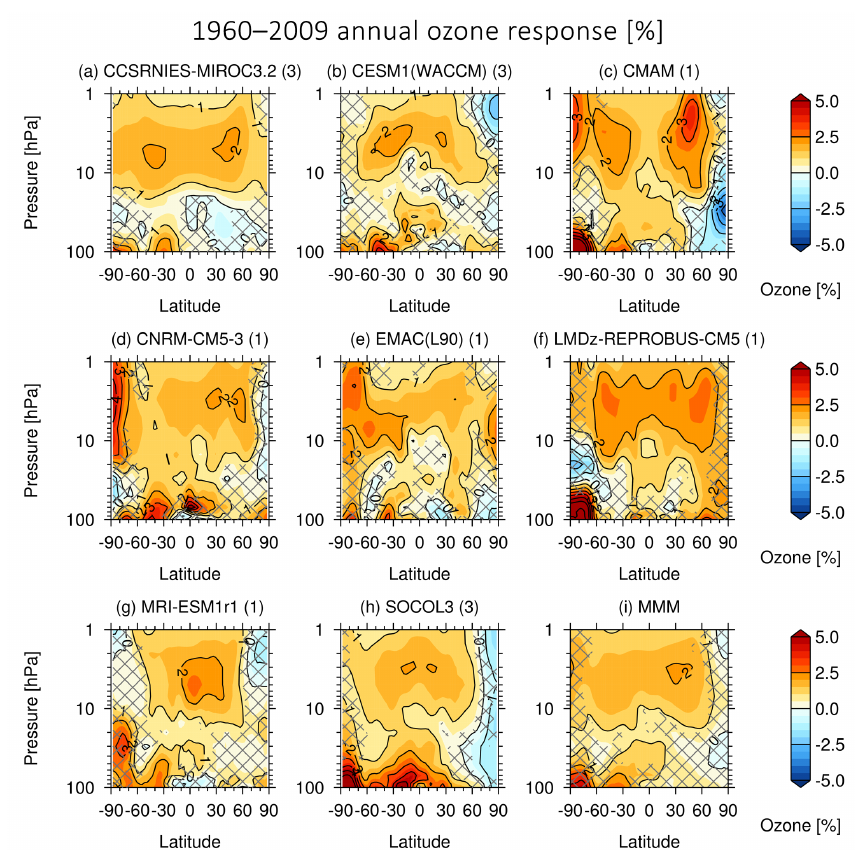
Figure 3. The percent (%) differences in stratospheric ozone mixing ratios per 130SFU derived for the period 1960–2009 in the CCMI- 1 models listed in Table 1. The solid contours denote 1% intervals. Hatching denotes regions where the regression coefficients are not significantly different from zero at the 95% confidence level. Panel (i) shows the multi-model mean (MMM), with hatching denoting where the MMM response is smaller than ± 2SD of the intermodel spread. The number of ensemble members used for each model is shown in parentheses in the